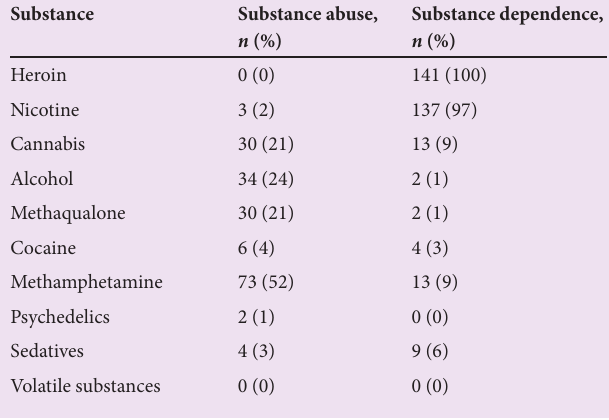
Table 3. Frequency of current comorbid substance use disorders in the sample ( N =141)